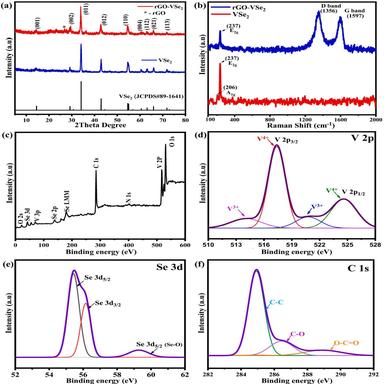
(a) XRD patterns of pure VSe2 and rGO-VSe2 nanohybrid; (b) Raman spectra of pure VSe2 and rGO-VSe2 nanohybrid; (c) Overall XPS spectra of rGO-VSe2 nanohybrid, and (d–f) high-resolution XPS spectra of V 2p, Se 3d, and C 1s.